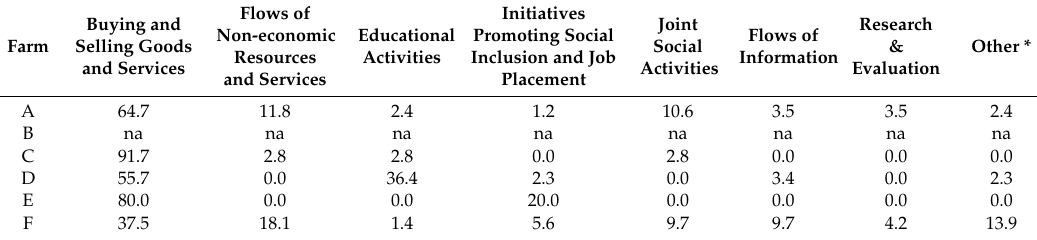
Table 5. Nature of the links made by participants with the reported alters (time point: